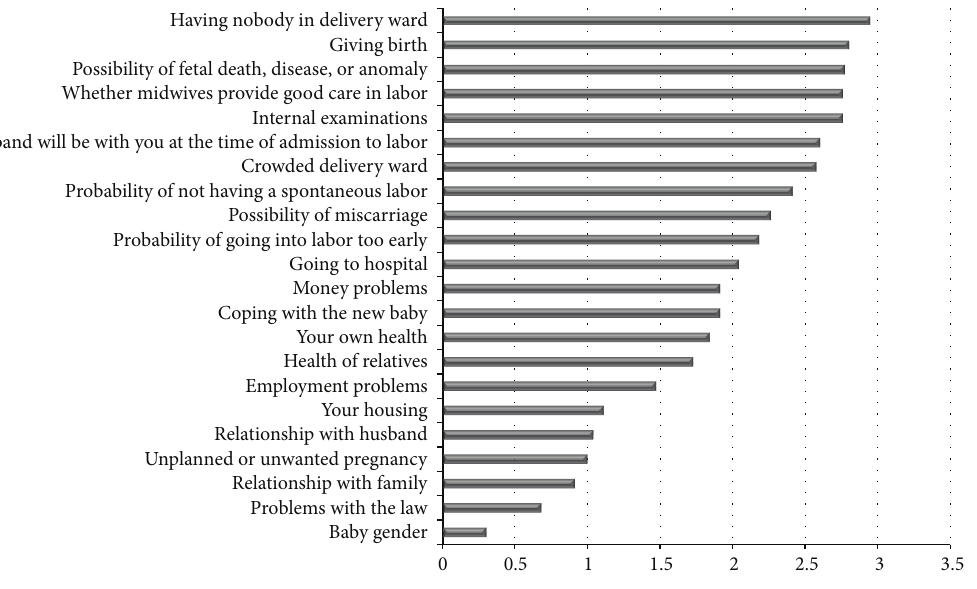
Figure 1: Ranking of women’s worries.